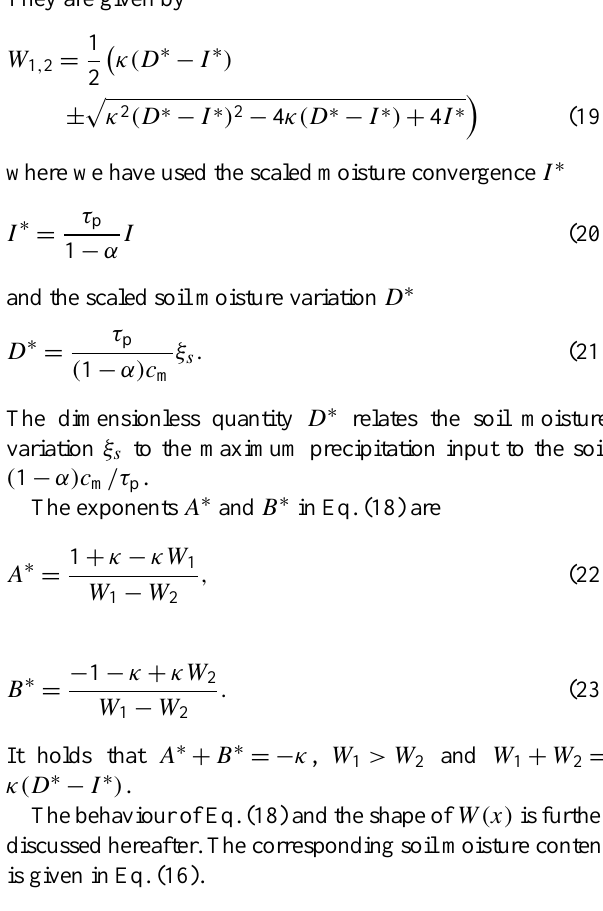
Fig. 2. Moisture profiles obtained with default parameter values (Ta- ble 2, L = 5400km) for W 0 = 0 . 5 (increasing regime) and W 0 = 1 . 0 (decreasing regime); the top plot shows atmospheric moisture, the bottom plot soil